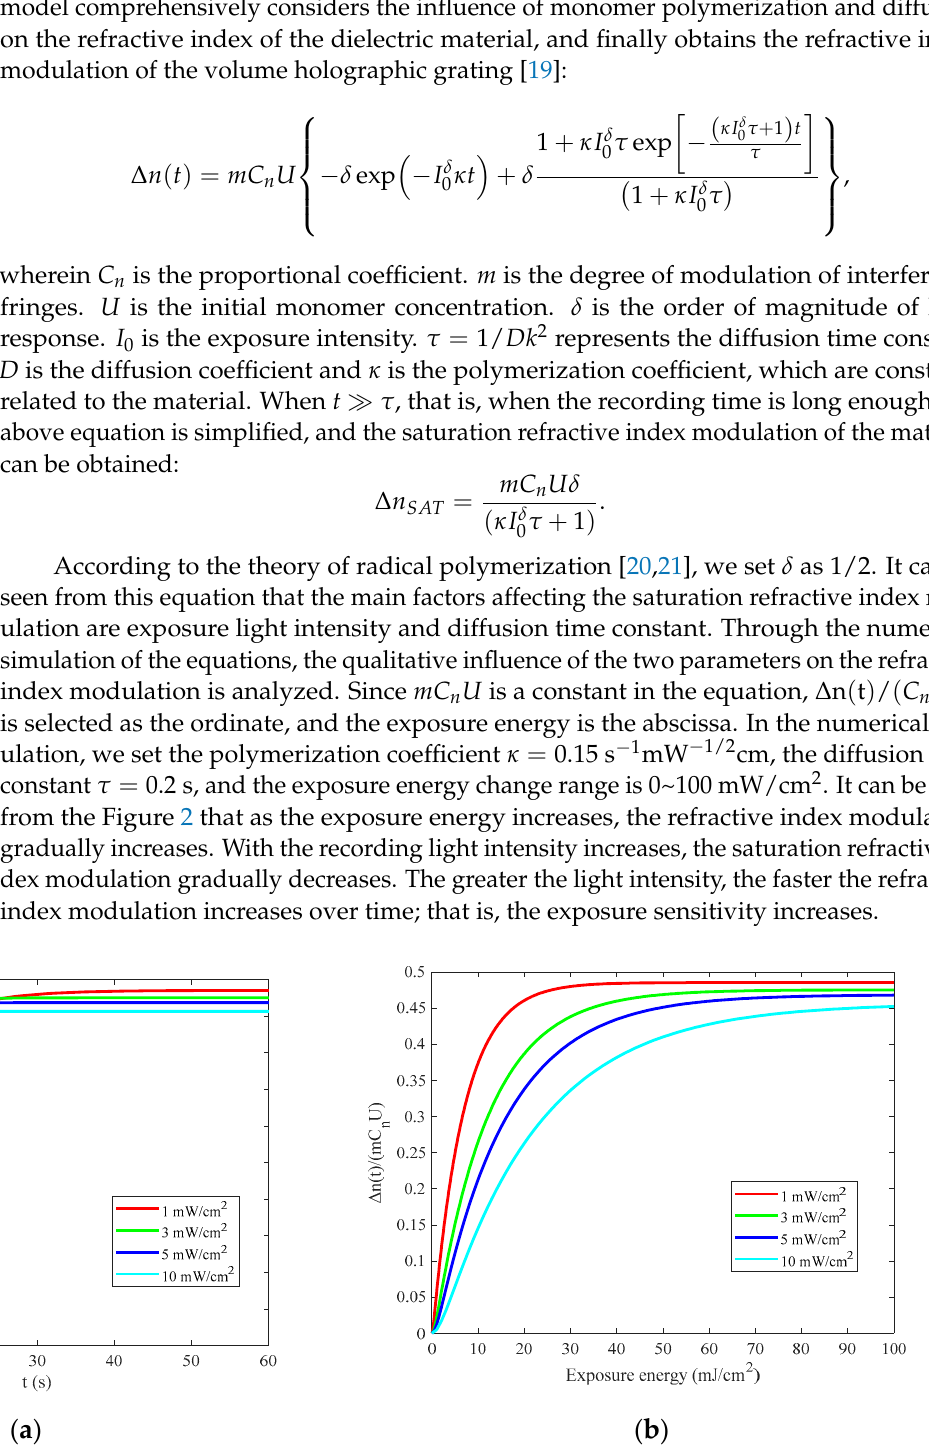
Figure 2. Analysis of factors affecting the refractive index modulation: ( a ) exposure time; ( b ) exposure energy.